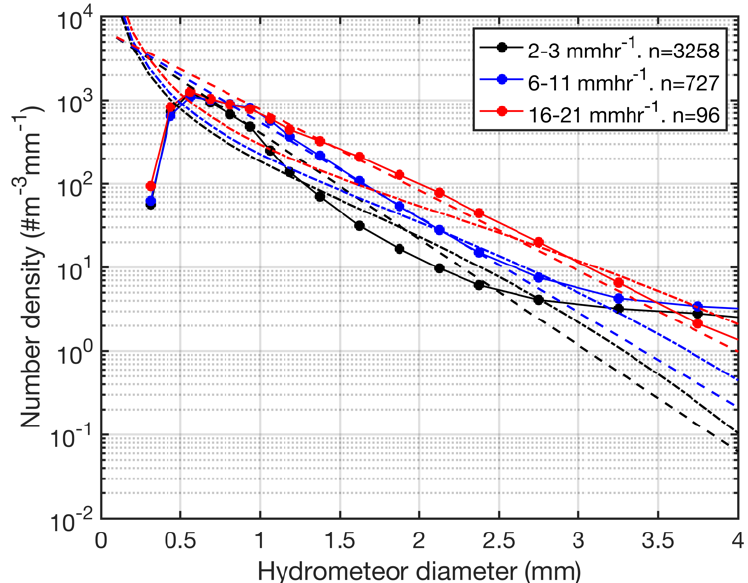
Figure 9. Mean droplet size distributions from the OTT Parsivel 2 disdrometer at the site in Denmark conditionally sampled for liquid precipitation only, for three different RR; 2–3 mmhr − 1 , 6–11 mmhr − 1 and 16–21 mmhr − 1 . The legend shows the number of 1 min periods (n) used to compute these mean DSD for each class of RR. Additionally, shown are the estimates of the DSD derived using Marshall-Palmer (dashed lines) and Best approximations (dashed-dot lines) for the mid-point of each RR range.